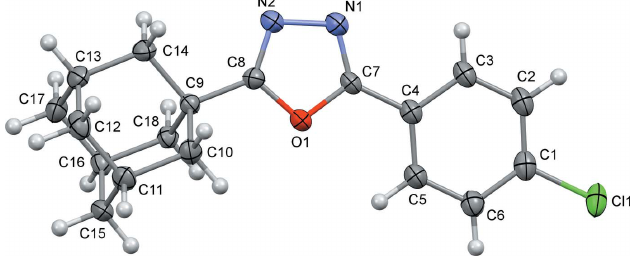
Figure 2 Molecular structure of compound (II), with the atom labelling and displacement ellipsoids drawn at the 50% probability level.